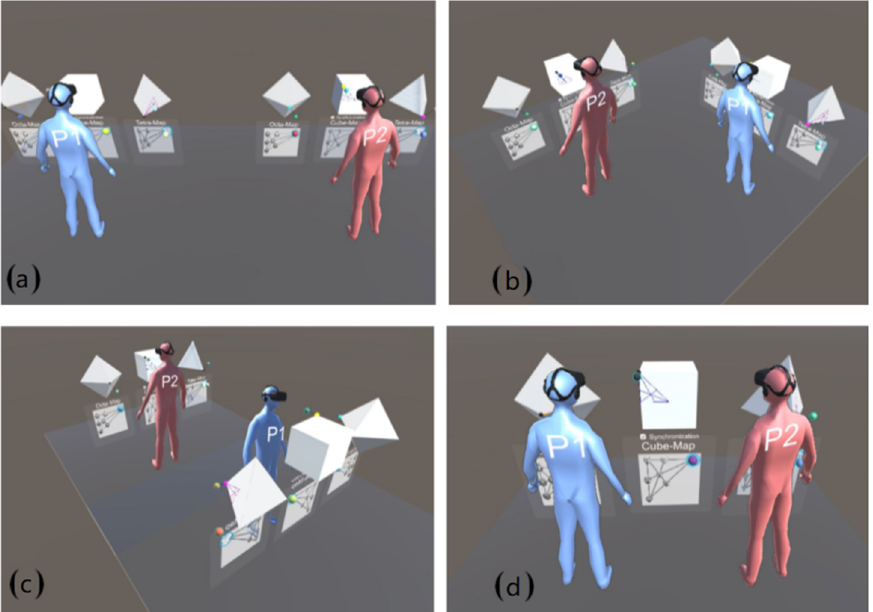
Figure 5. The position arrangements: ( a ) side-by-side; ( b ) corner-to-corner; ( c ) back-to-back; and ( d ) public workspace. ( a – c ) are available to both Shared and Non-Shared users, while ( d ) is only for the Shared group.